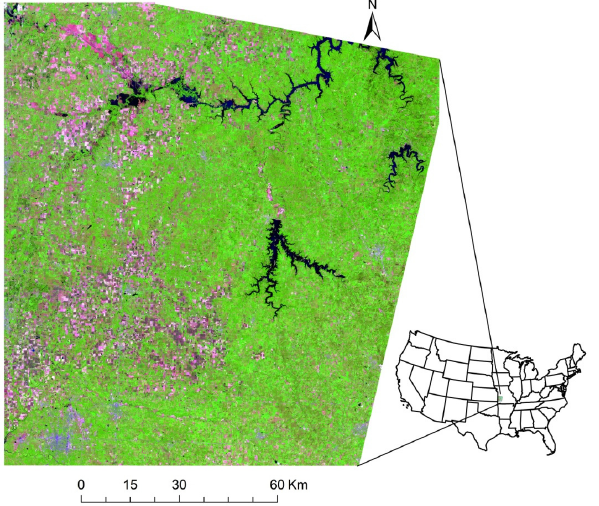
Figure 2. An example TM image of study area acquired on DOY 140, 2007 (R: band 5, G: band 4, B: band 3).